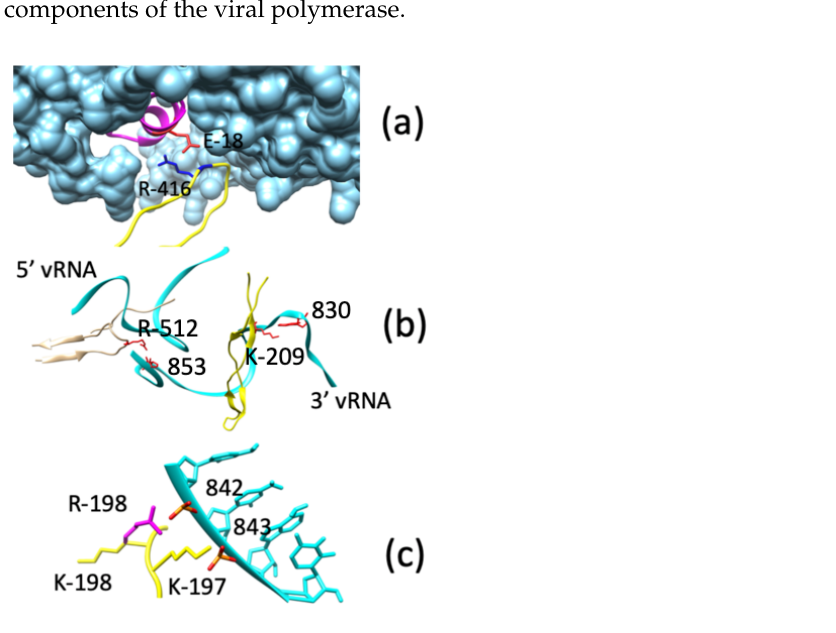
Figure 7. Interactions between POL and NP–vRNA. ( a ) The folded domain from NP-33 (residues 405–422, yellow) interacts with PB1 (cyan) and PB2 (magenta) of the polymerase. Residue R416 (blue) of NP-33, and E18 (red) of PB2 form a salt bridge. ( b ) Additional salt bridges are formed by the 3 (cid:48) end of vRNA (cyan) to the polymerase subunits: A830 to K209 of PA (shown in yellow), and U853 to R512 within a hairpin structure of PB1 (shown in tan). ( c ) K198 of PB1 (yellow) points away from vRNA, while the K198R mutation (magenta) allows for a salt bridge to form with the phosphate group of C842 of the vRNA. The larger R198 side-chain thus causes an increase in POL-binding to